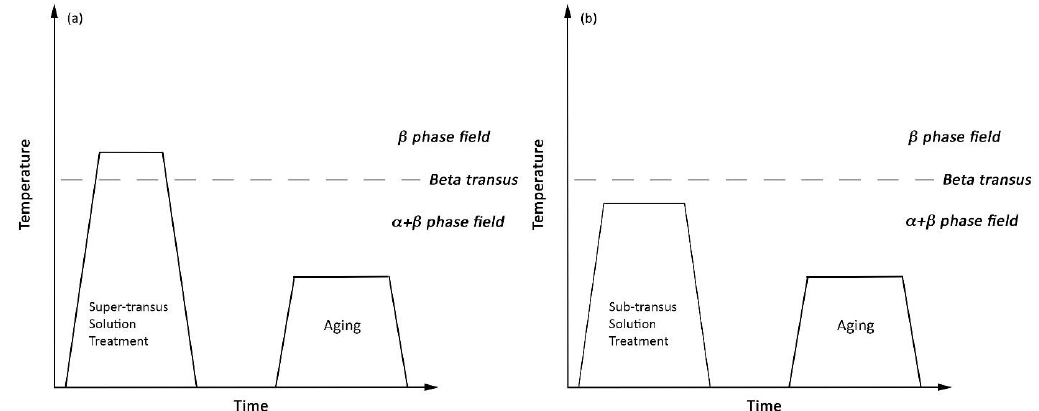
Figure 10. A schematic illustrating the qualitative difference between ( a ) super-transus solution treatment in the β -phase field and, ( b ) sub-transus solution treatment in the α + β dual-phase field followed by isothermal aging.